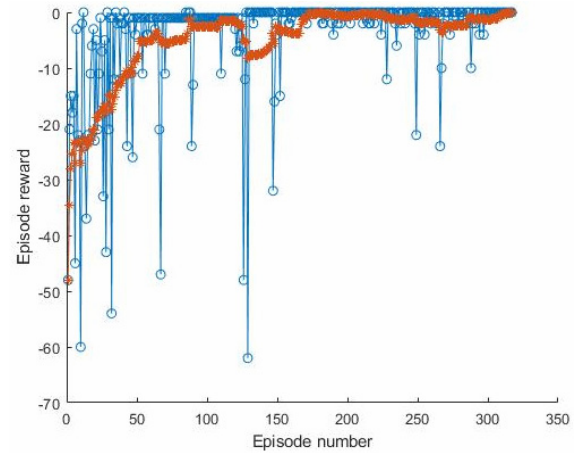
Figure 9. Rewards vs. training episodes. Expected return for every episode (light grey). 20 episodes-averaged reward (dark grey) is considered for terminating the training sequence